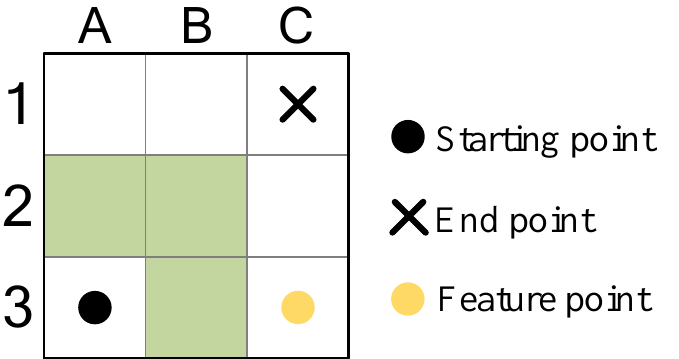
Figure 3. inconsistent expand of